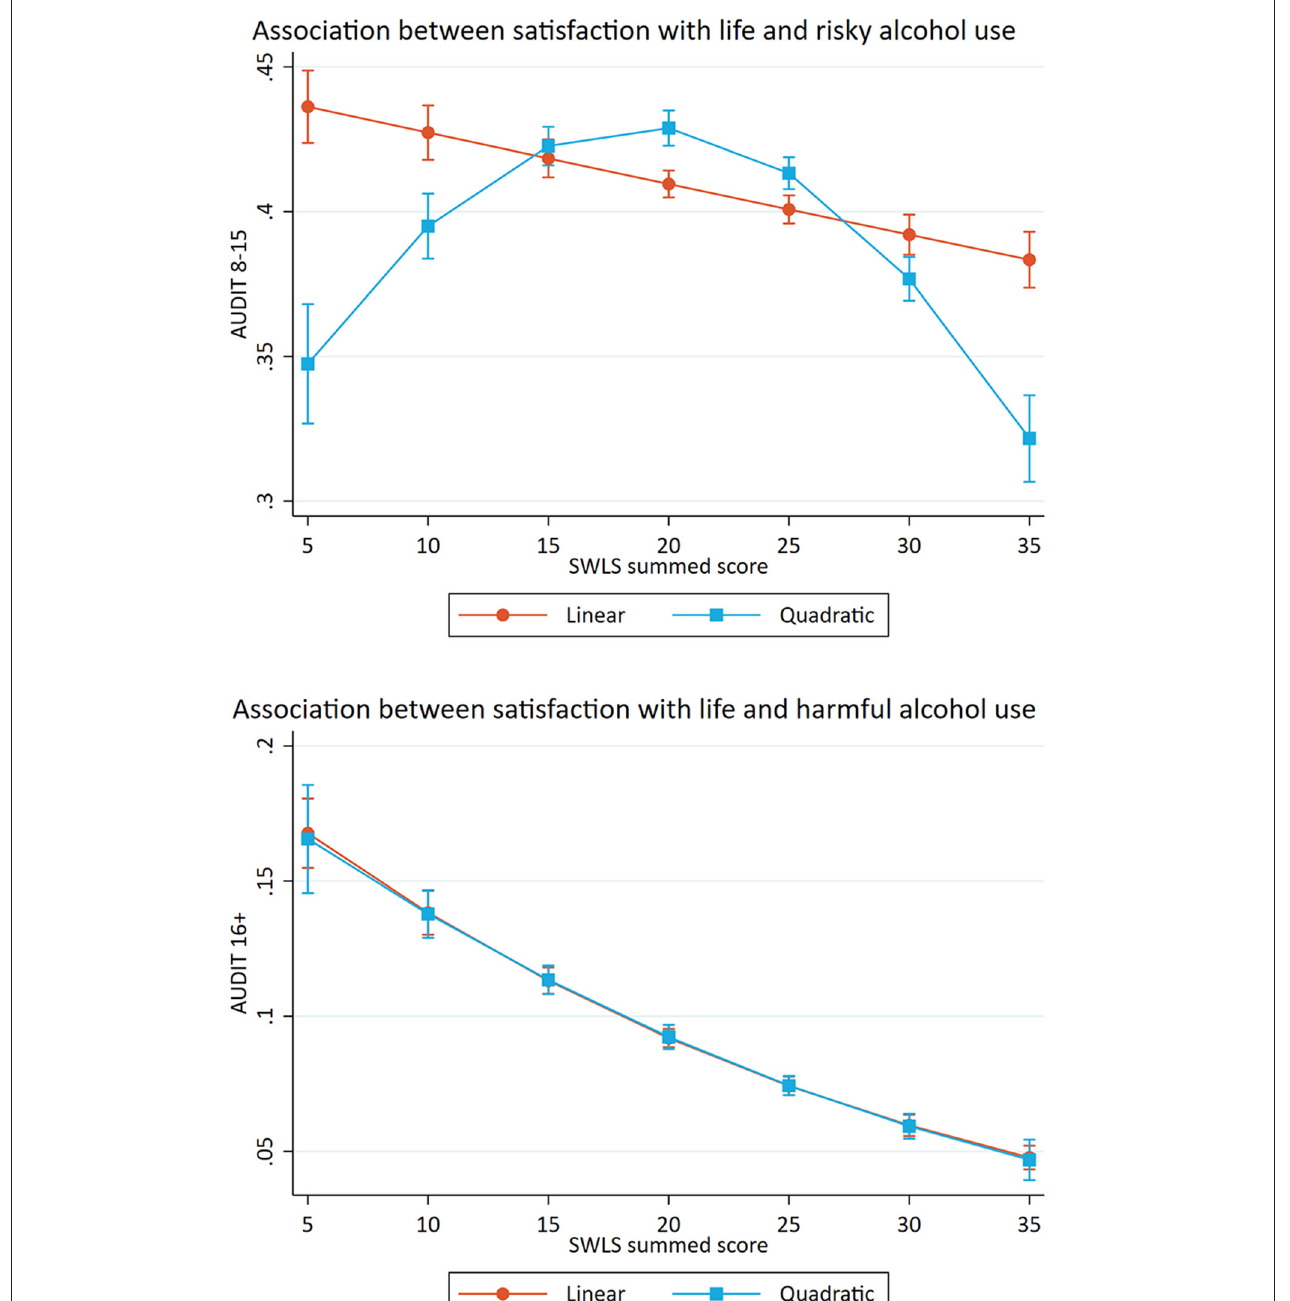
FIGURE 1 | Associations between satisfaction with life and potential alcohol-related problems. Predicted probabilities of alcohol-related problems (The Alcohol Use Disorders Identification test; AUDIT) across summed scores on satisfaction with life scale (SWLS). Error bars represent 95% confidence intervals.